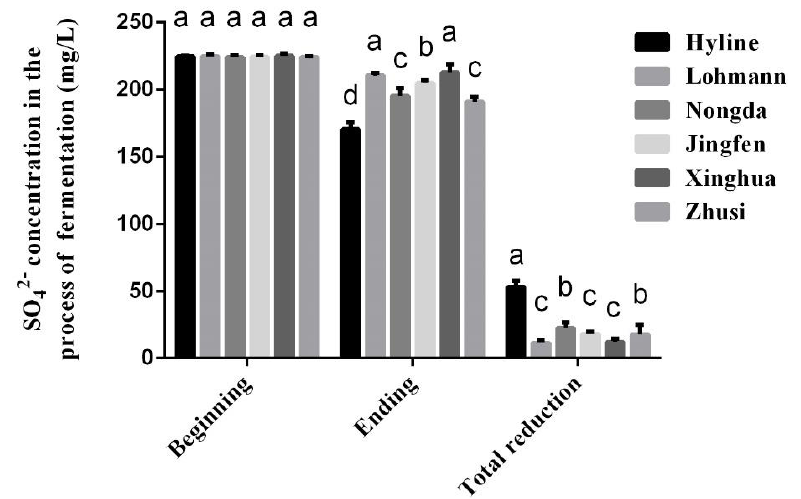
Figure 2. The changes in SO 42 − concentration during the fermentation processes ( n = 5). Superscript letters a-d indicate differences between means within each species ( p < 0.05).